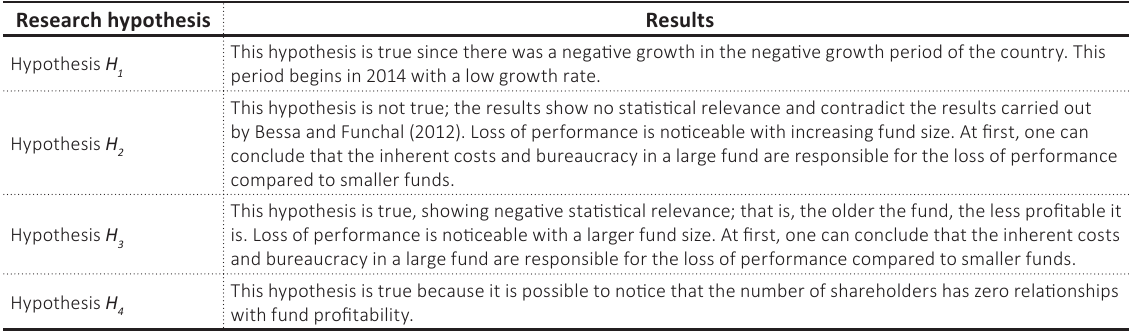
Table 7. Summary of the results